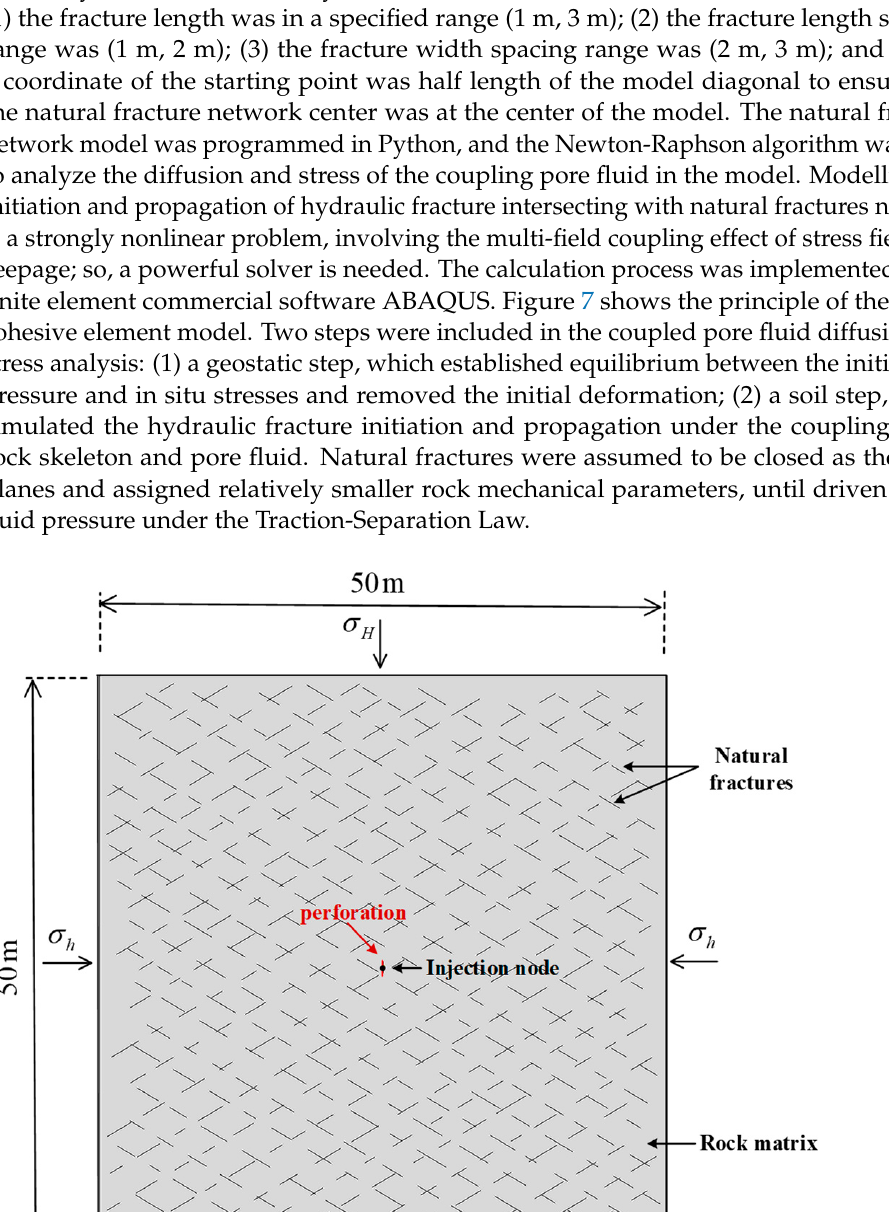
Figure 7. Schematic diagram of the natural fractures network model established using global cohe- sive elements. ( a ) Mesh generation of the natural fractures network model. ( b ) The mesh is locally enlarged to show the location of the natural fracture more clearly. ( c ) Mesh before embedding co- hesive element. ( d ) Mesh after global embedding cohesive elements. Table 1. Relevant parameters for the model. Parameter